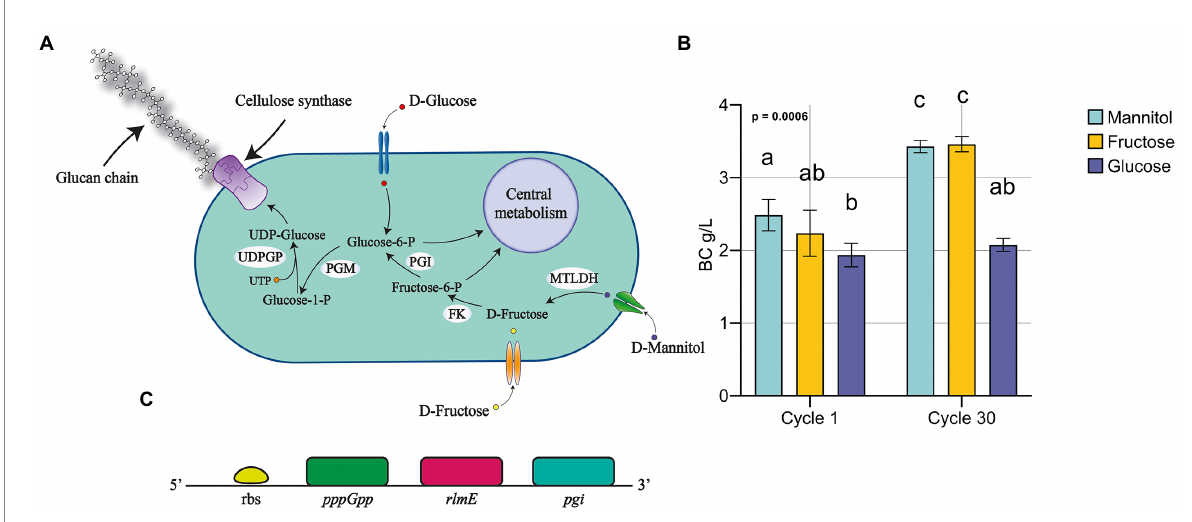
FIGURE 4 Fructose utilization as carbon source for BC production: (A) schematic illustration of fructose and mannose metabolic pathway, focusing on the bioconversion of mannitol for BC production; (B) BC production using fructose and comparison among MA, MF and GC. Data were represented as mean ± standard deviation. Tukey test was used to assess multiple comparison among conditions. Different letters indicate statistical differences among conditions ( p < 0.05); (C) schematic representation of pgi related gene disposition in K. xylinus K2G30